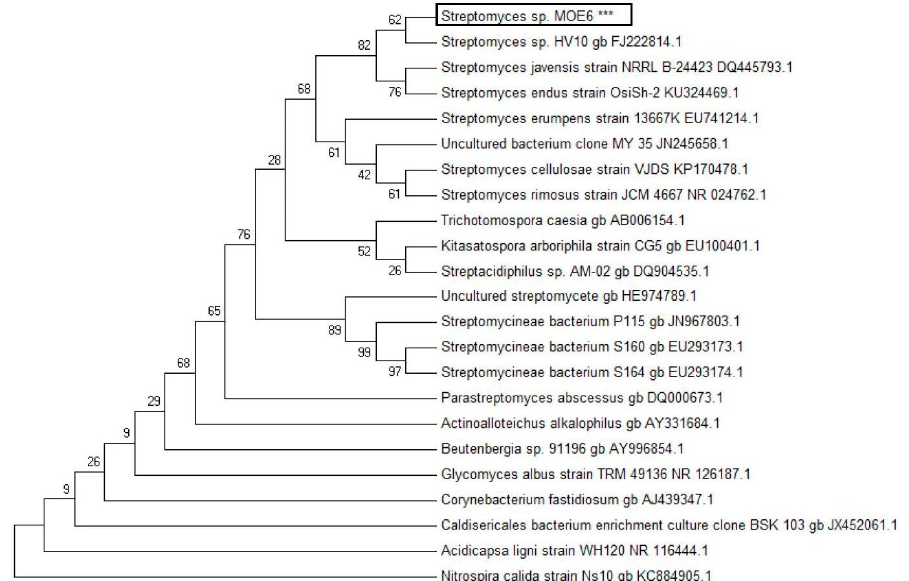
Figure 1. Maximum likelihood phylogenetic tree of the isolated strain Streptomyces sp . MOE6 based on 16S rRNA gene sequencing of a 1471 bp fragment. *** indicates the MOE6 isolate.